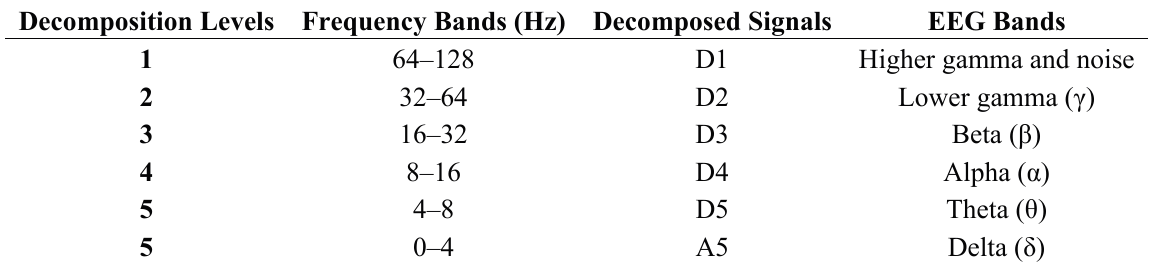
Table 2. The EEG signal decomposition into five frequency bands and